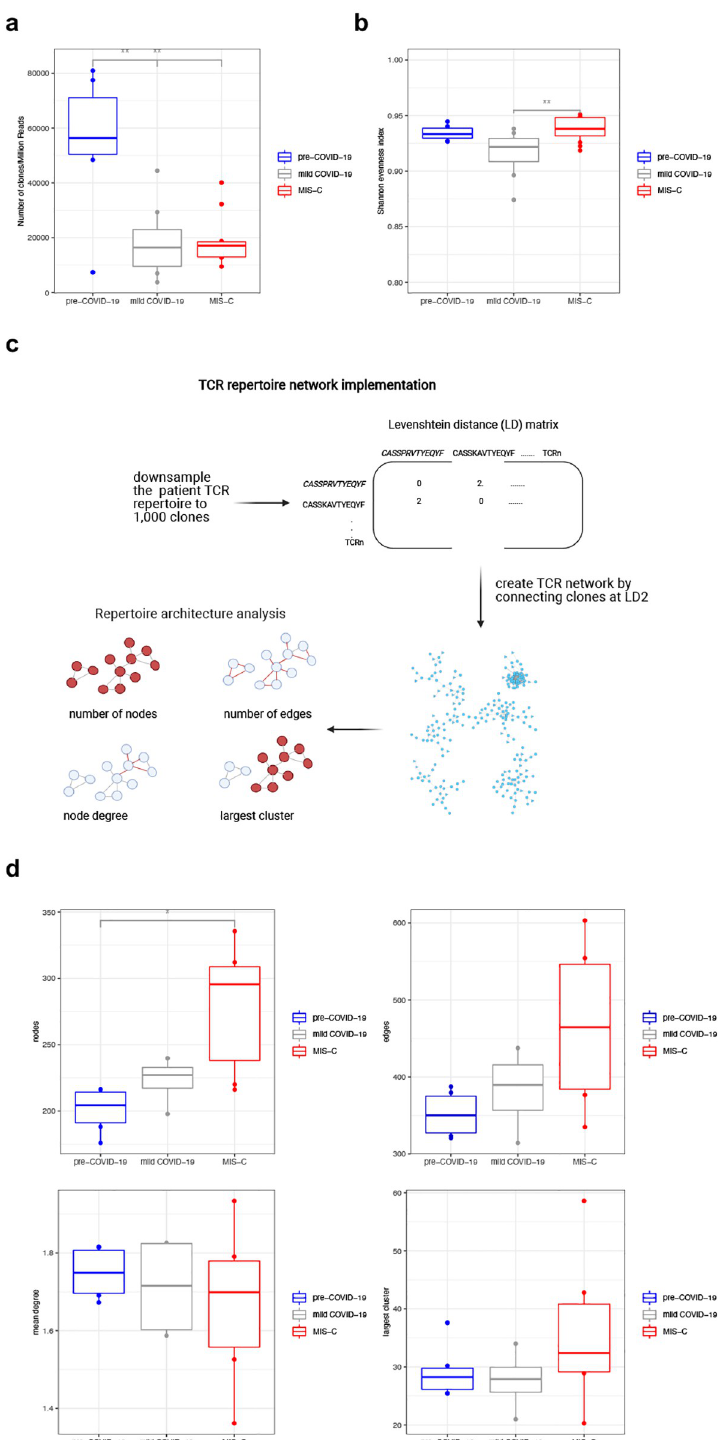
Fig 2. The expansion of TRBV11-2 in children with MIS-C doesn’t alter the TCR repertoire’s overall architecture. (a, b) TCR repertoire metrics of patients. Significance determined by unpaired Wilcoxon test between each pediatric group, with adjustment for multiple comparisons using Benjamini-Hochberg correction, indicated by: � p < 0.05, �� p < 0.01, and ��� p < 0.001. Lack of notation for specified comparisons indicates no statistical significance. (c) Overview of sequence similarity network analysis: Each repertoire was downsampled to 1,000 clones. Pairwise amino acid